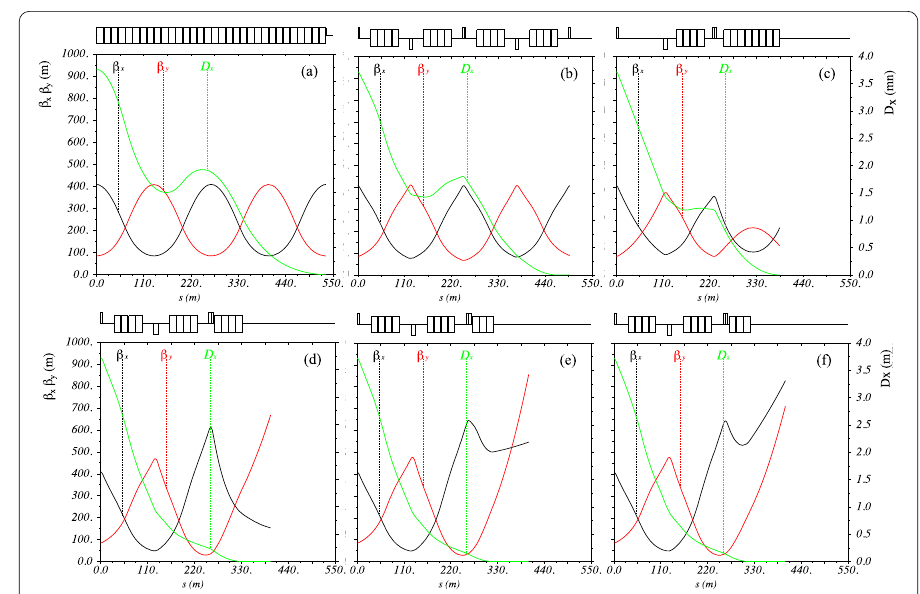
Figure 4 Possible layouts of dispersion suppressor sections based on CF main magnets and standard quadrupoles to be used in combination with the optimised CF cell layout presented in the previous section. The evolution of the optical parameters and dispersion function as a function of s is shown, together with a sketch of each layout on top of the plot: CF main magnets (rectangles centred around the middle line) and quadrupoles (rectangle above or below the centre line to represent their polarity) are shown. The layout (a) is the starting point, made of CF main magnets with half of the bending field of the magnets in the regular CF cell. All other cases refer to variants with CF main magnet with the same properties of those in the CF cell. The length of the dispersion suppressor, given by the condition D x = D (cid:3) x = 0, decreases for the different